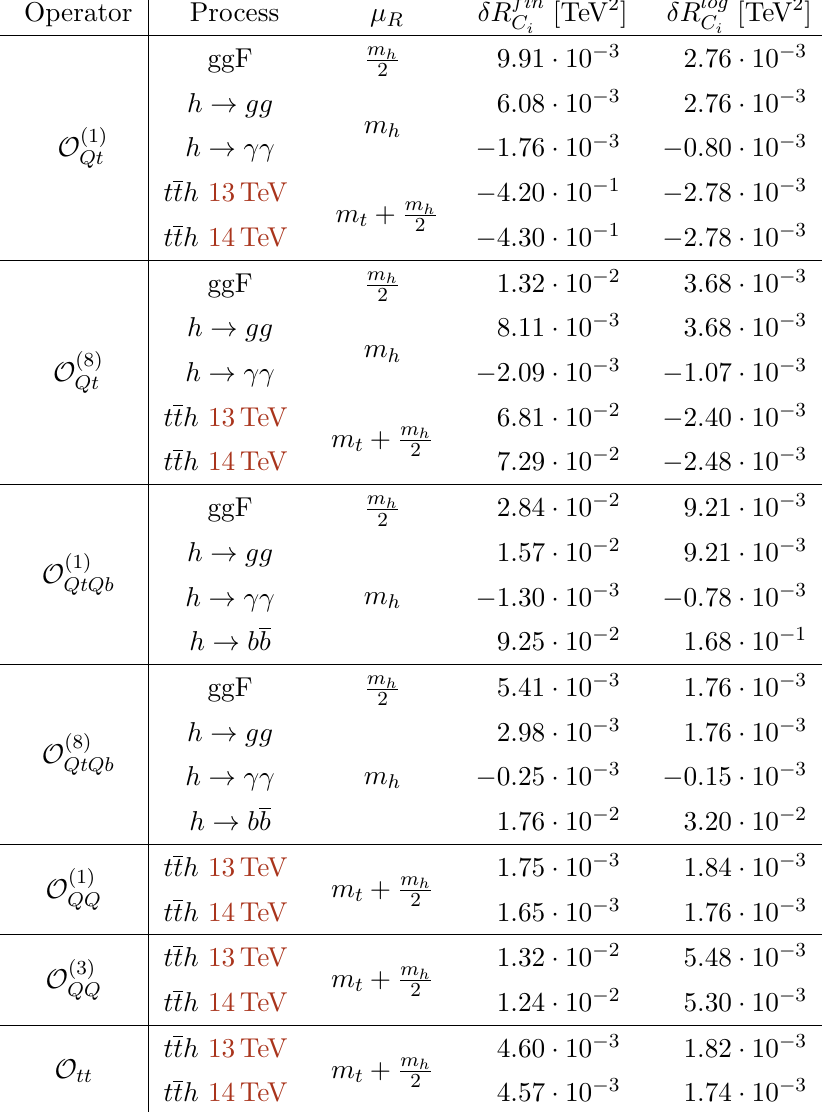
Table 1 . The NLO corrections to single Higgs rates from the four heavy-quark SMEFT operators of this study. We have separated the contributions into the finite piece, δR fin log running of the Wilson coefficients, δR log